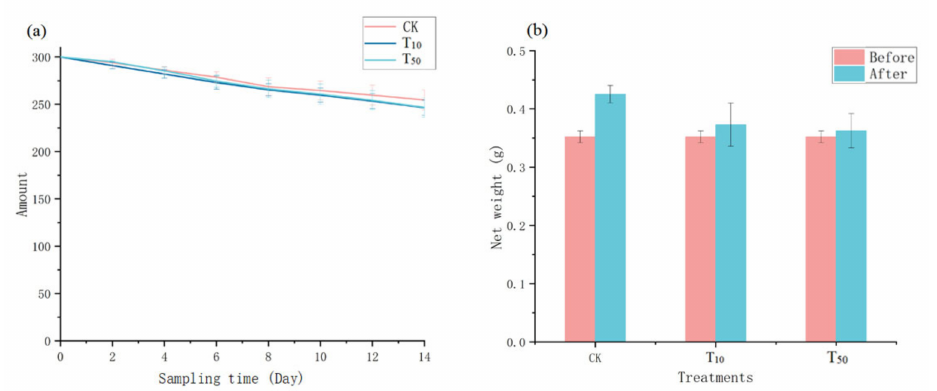
Figure 1. The number of living earthworms ( a ) and their weight changes ( b ). Error bars indicate standard deviations ( n = 3). CK, T 10 , and T 50 represent the treatment groups with 0, 10, and 50 mg/kg arsenic added,